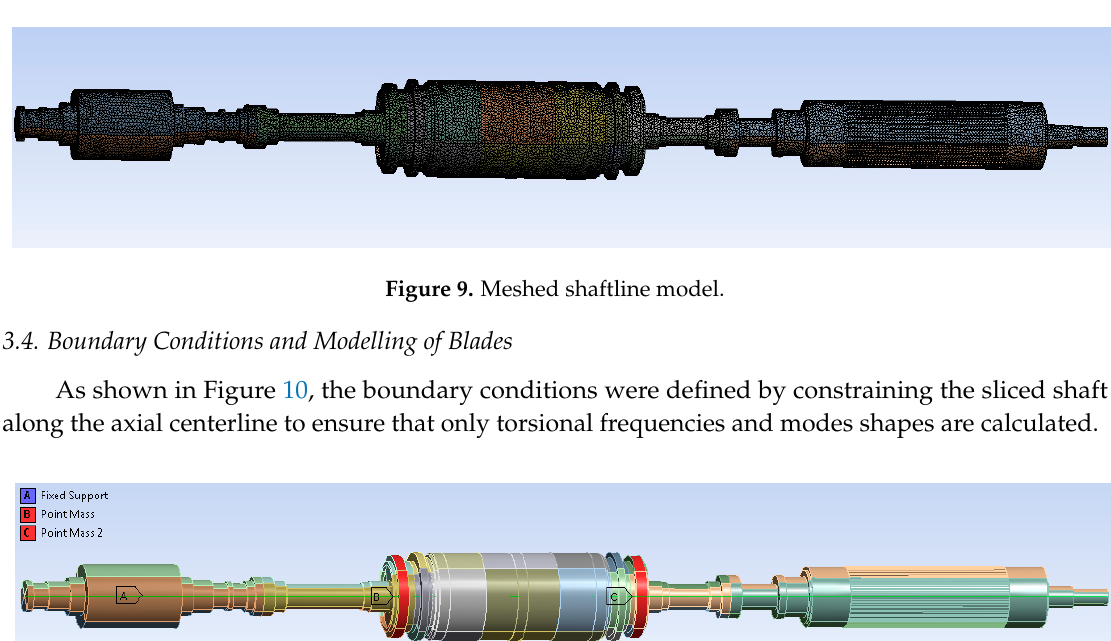
Table 1. Shaftline material properties.